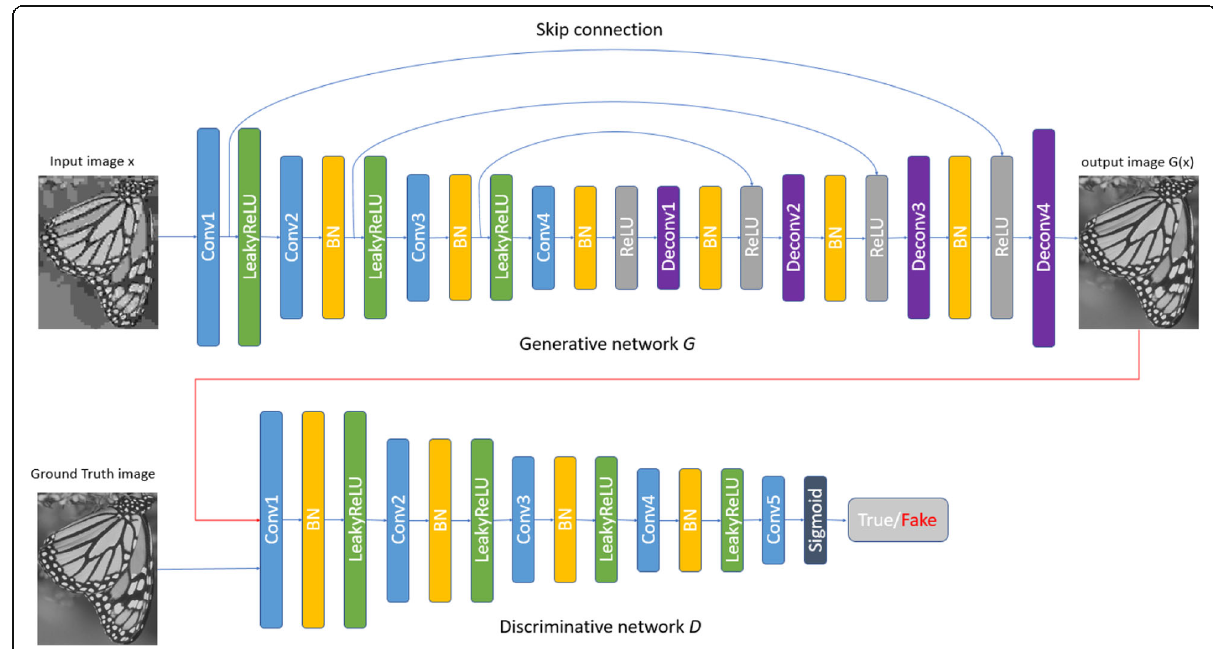
Fig. 1 Architecture of the proposed